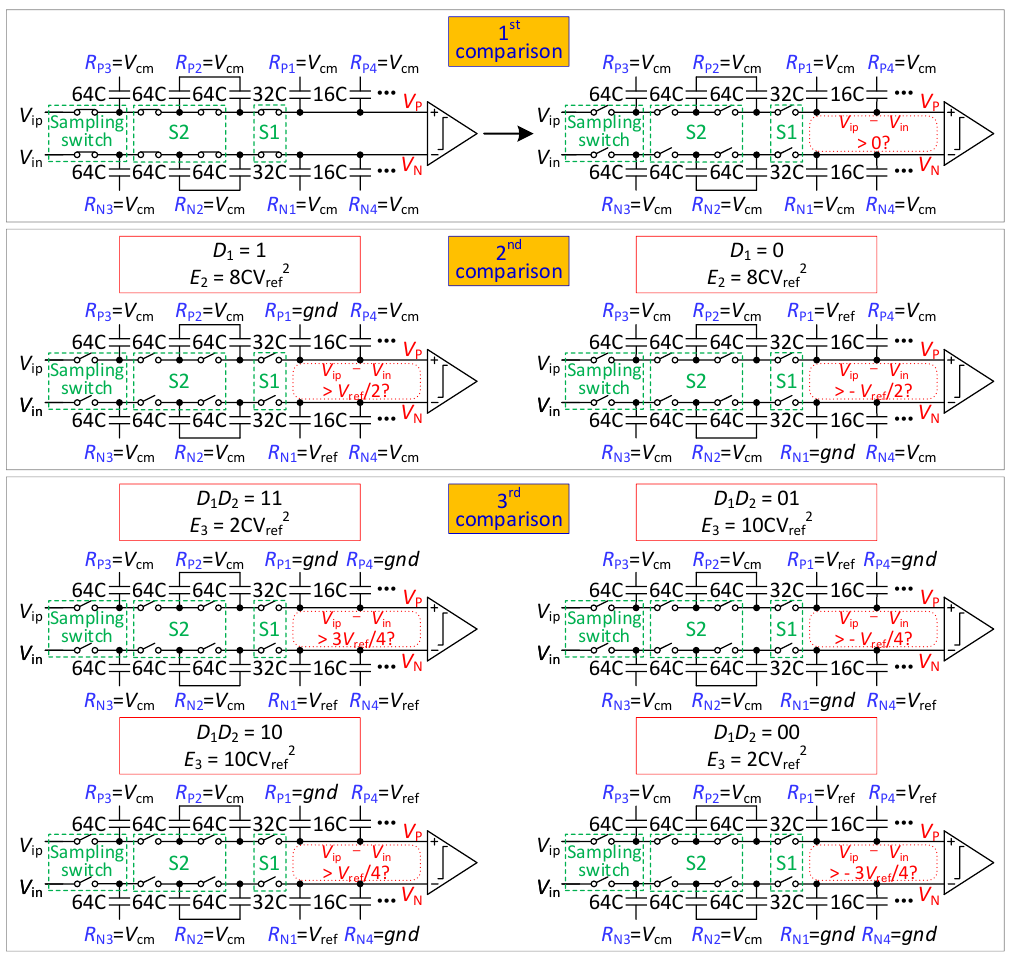
Figure 2. Proposed 8-bit mode switching scheme.